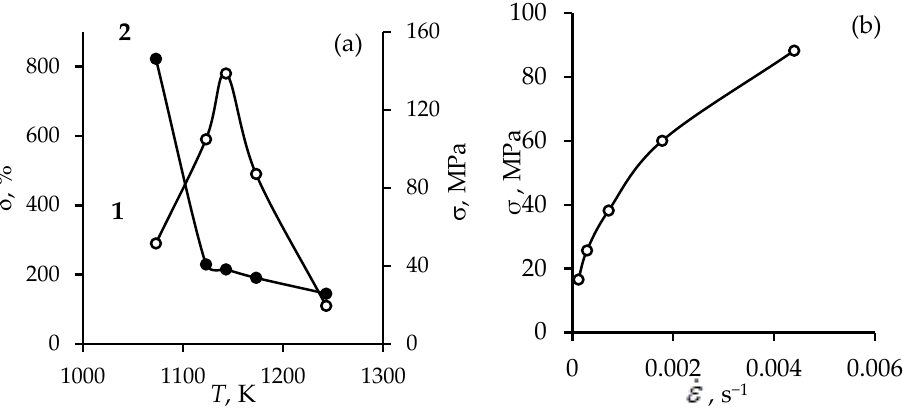
Figure 8. The mechanical properties of the Co-Ni-Nb alloy at the superplastic deformation. Dependencies of the relative residual elongation ( δ ) (curve 1 ) and the tensile strength ( σ ) (curve 2 ) on the superplastic deformation temperature ( T ) obtained at velocity = 0.72 × 10 − 3 s − 1 ( a ) and dependence of the tensile strength ( σ ) on the stretching speed ( ) at T = 1143K ( b ).